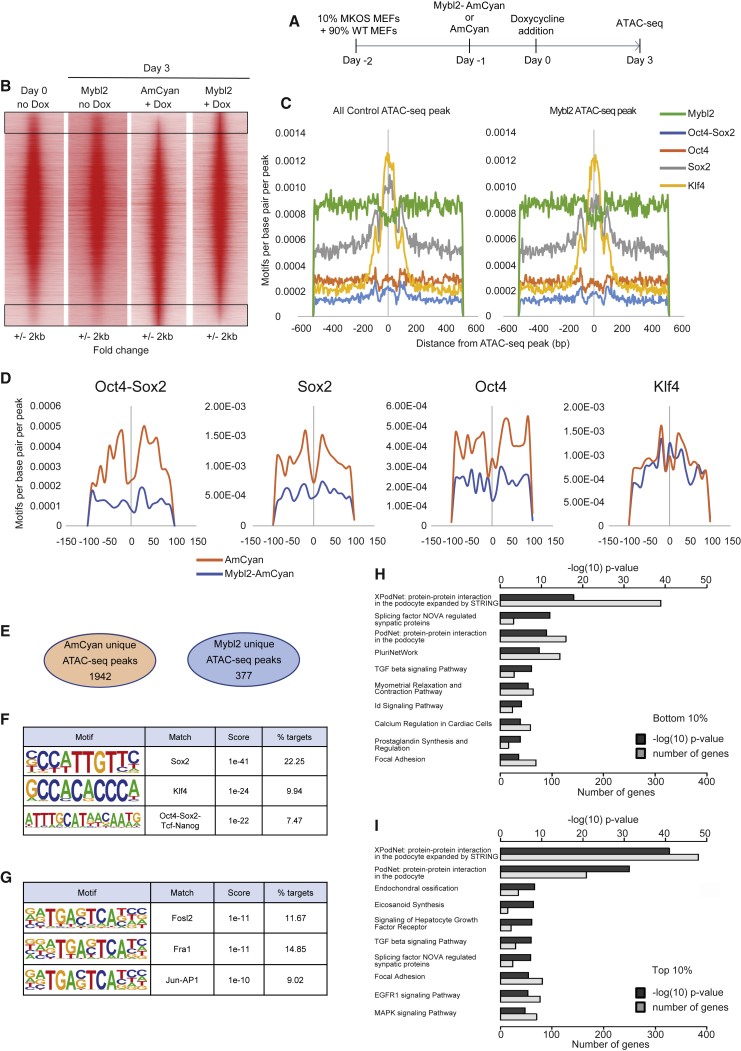
Mybl2 Overexpression Changes the Chromatin Landscape in the Initiation of Reprogramming of Tg Reprogrammable MEFs(A) Schematic representation of the experimental design.(B) Profiles of the ATAC-seq signals within each 1,000-bp window centered on each peak for Tg MEFs at time zero (day 0 no dox) (n = 2 biological replicates), Tg MEFs 4 days after Mybl2-AmCyan infection, no reprogramming (Mybl2 no dox) (n = 2 biological replicates), and Tg MEFs infected with AmCyan or Mybl2-AmCyan and 3 days after dox addition (AmCyan + dox, Mybl2-AmCyan + dox, respectively) (n = 3 biological replicates). Peaks are shown in the order of decreasing ATAC-seq tag count signal for Mybl2-treated relative to control (AmCyan).(C) Reprogramming pioneer factor and Mybl2 motif density within each 200-bp window centered on each peak in all control ATAC-seq peaks compared to all Mybl2 ATAC-seq peaks.(D) Reprogramming pioneer factor motif density in top 10% (blue) or bottom 10% ATAC-seq peaks (orange) from the union of peaks between control and Mybl2 overexpressed cells at day 3 of reprogramming.(E) Number of unique ATAC-seq peaks in control and treated cells after performing differential peak detection.(F) Motif enrichment analysis in unique control ATAC-seq peaks at day 3 of reprogramming.(G) Motif enrichment analysis in Mybl2-AmCyan ATAC-seq peaks at day 3 of reprogramming.(H) Gene Ontology (GO) analysis for the closest gene to unique ATAC-seq peaks present in AmCyan control at day 3 of reprogramming (bottom 10%).(I) GO analysis for the closest gene to unique ATAC-seq peaks present in Mybl2-AmCyan at day 3 of reprogramming (top 10%).See also Figure S7.